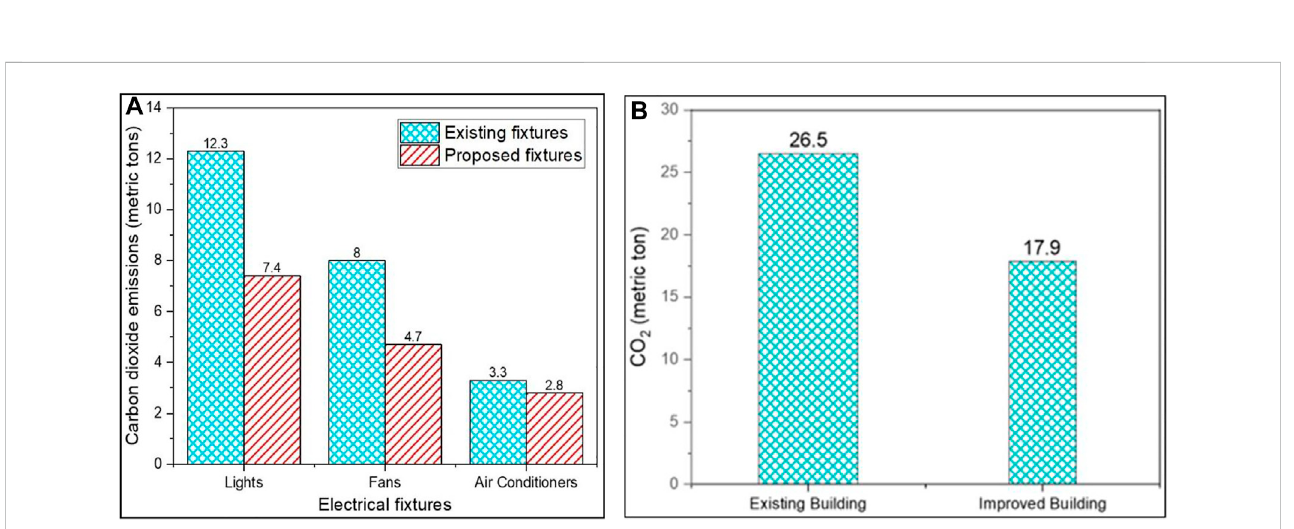
FIGURE 8 (A) ComparisonofreductioninCO 2 emissionsbeforeandafterretro fi ttingmeasuresinelectrical fi xturesand (B) overallreductioninCO 2 emissionofthe building after retro fi tting.